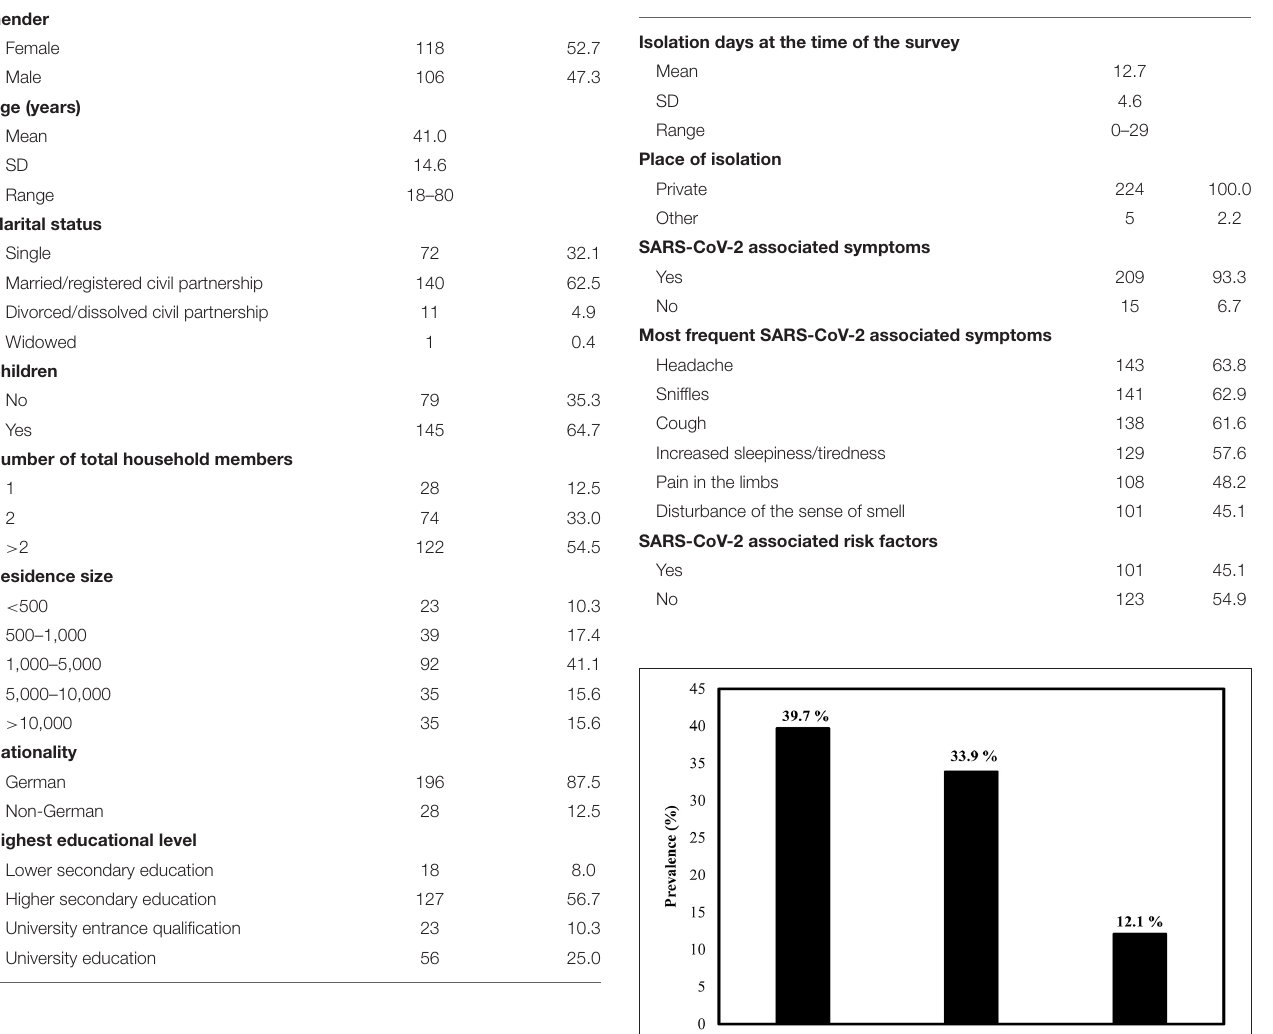
= 40.0, U = 4,161.0, z = − 4.3, p < 0.001, and r = 0.3). (3) Specific stressors arising from SARS-CoV-2 infection and isolation: Respondents with psychological burden ( Mdn = 37.3) perceived stressors arising from SARS-CoV-2 infection and isolation significantly more strongly than